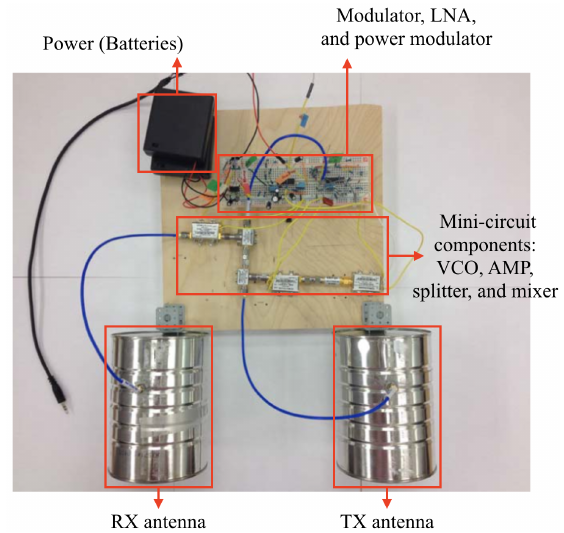
Figure 2. Original hardware design of the radar system (version zero).